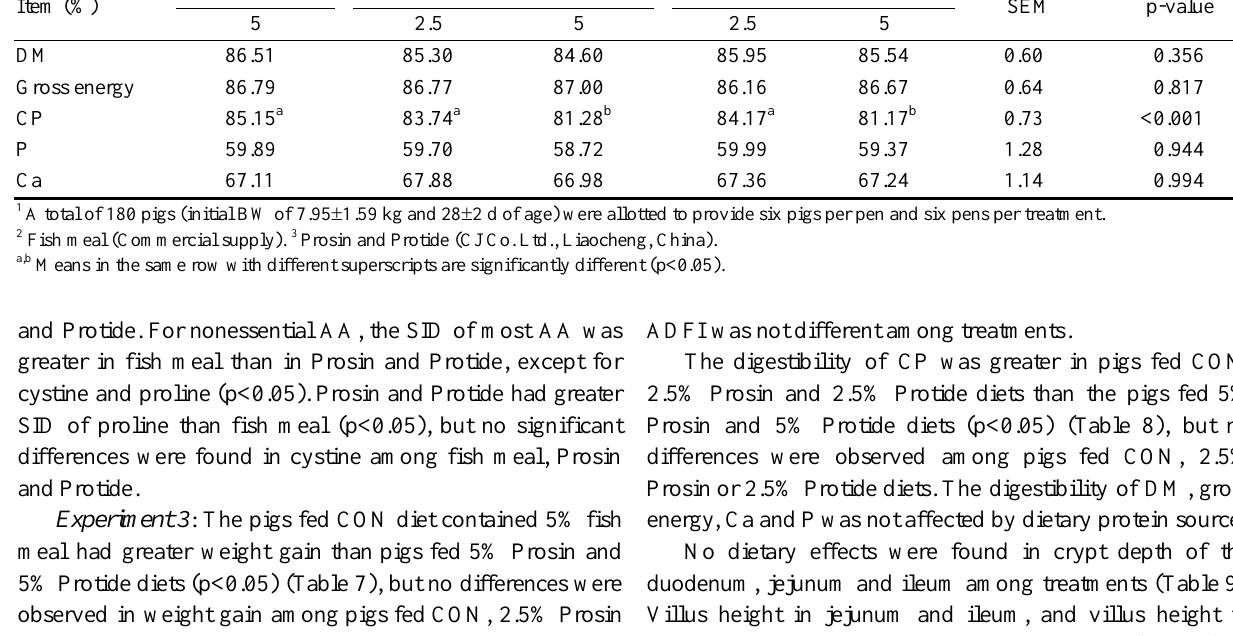
Table 8. Effects of single-cell proteins (Prosin and Protide) replacing fish meal in diet on nutrient digestibility of weaned piglets, Exp. 3 1 Fish meal 2 (%) Item (%)